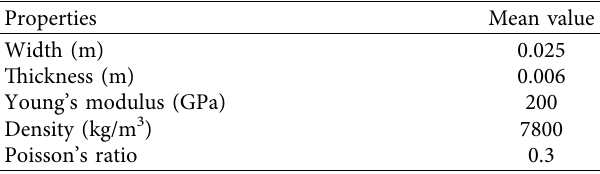
Table 1: Dimensions and material properties.